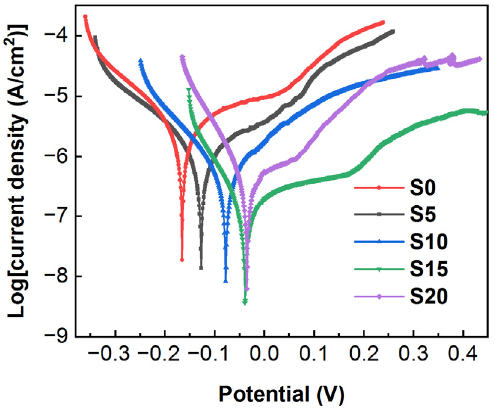
Figure 8. Potentiodynamic polarization curves of all samples. Table 3. Results of potentiodynamic polarization test in 3.5 wt.% NaCl solution.